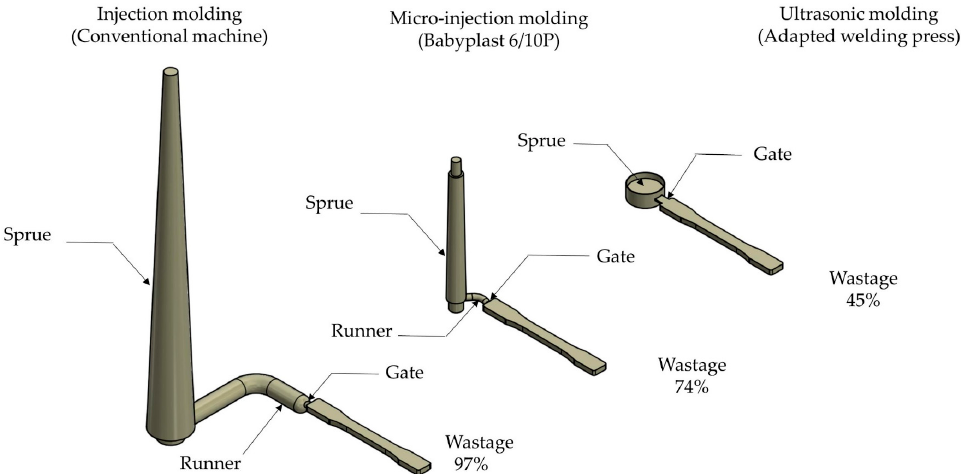
Figure 11. Qualitative comparison among different feeding systems (sprue + runners + gates) against ultrasonic molding sprue and runners.